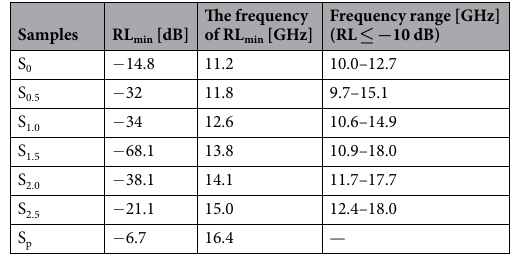
Table 1. The minimum reflection loss value (RL min ), the frequency of RL min and the absorption bandwidth of differents samples under the thickness of 2.2 mm.